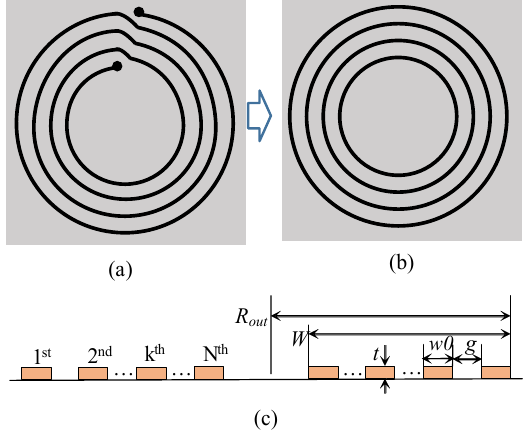
Figure 1. Illustrations of ( a ) a printed spiral coil, ( b ) a concentric multi-loops coil equivalent to the spiral coil, and ( c ) their cross-sections.